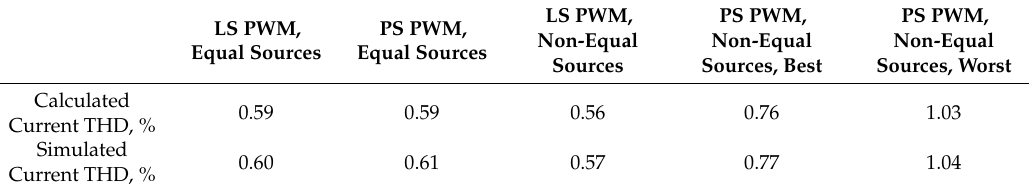
Table 3. Current THD for a Single-Phase Four H-Bridge CHB.